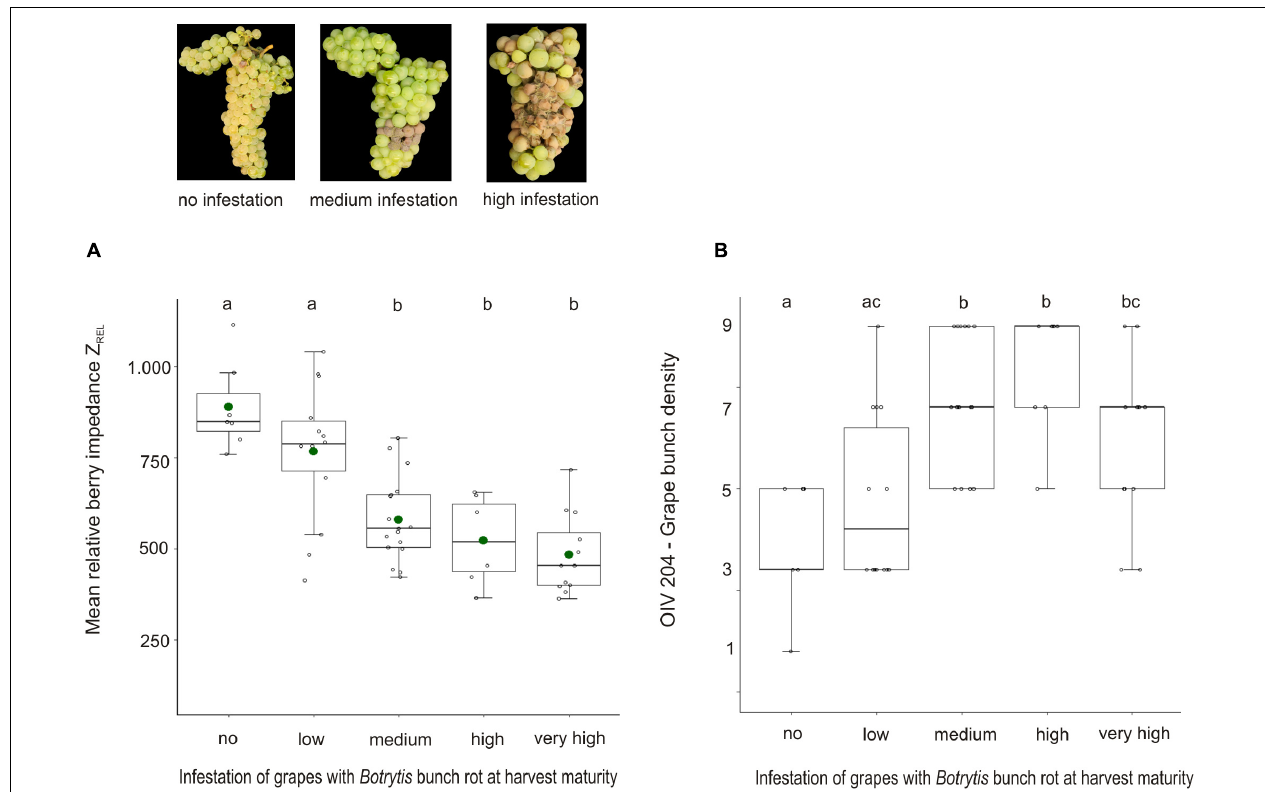
FIGURE 2 | Mean berry impedance Z REL (A) and grape bunch density factor OIV 204 (B) of 28 varieties with, on average, 17 ◦ Brix in relation to the infection of grapes with Botrytis bunch rot at harvest in seasons 2017 and 2021. Samples were grouped according to infection with Botrytis bunch rot that was scored right before harvest. Detailed information about underlying varieties, year of investigation, their stage of maturity at harvest, and Botrytis infection is given in Supplementary Table 2 . N (= replicates) per infection group: “no” = 7, “low” = 14, “medium” = 17, “high” = 7, and “very high” = 12. Mean Z REL and Botrytis bunch rot infection was determined in one to six replicates per variety (see Supplementary Table 2 ). Different letters indicate significant differences. Green dots display the mean values. N =